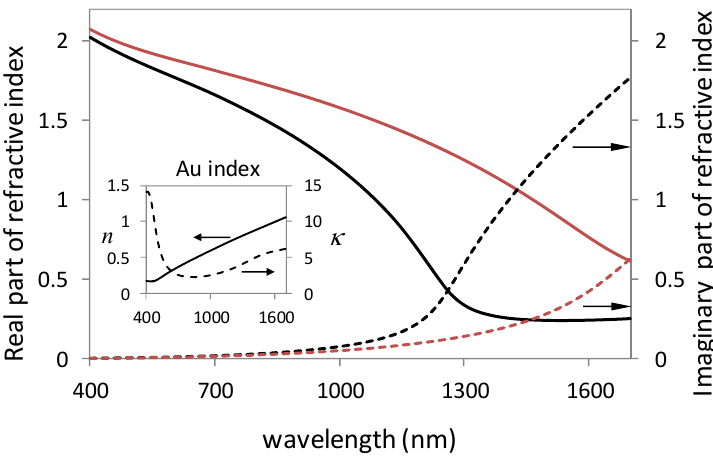
Figure 5. Complex index of refraction ( n + i κ ) of two ITOs (black: 200 nm thick Delta Technology, red: 45 nm thick Thin Film Devices) measured by ellipsometer. The inset shows a complex index of refraction of gold from